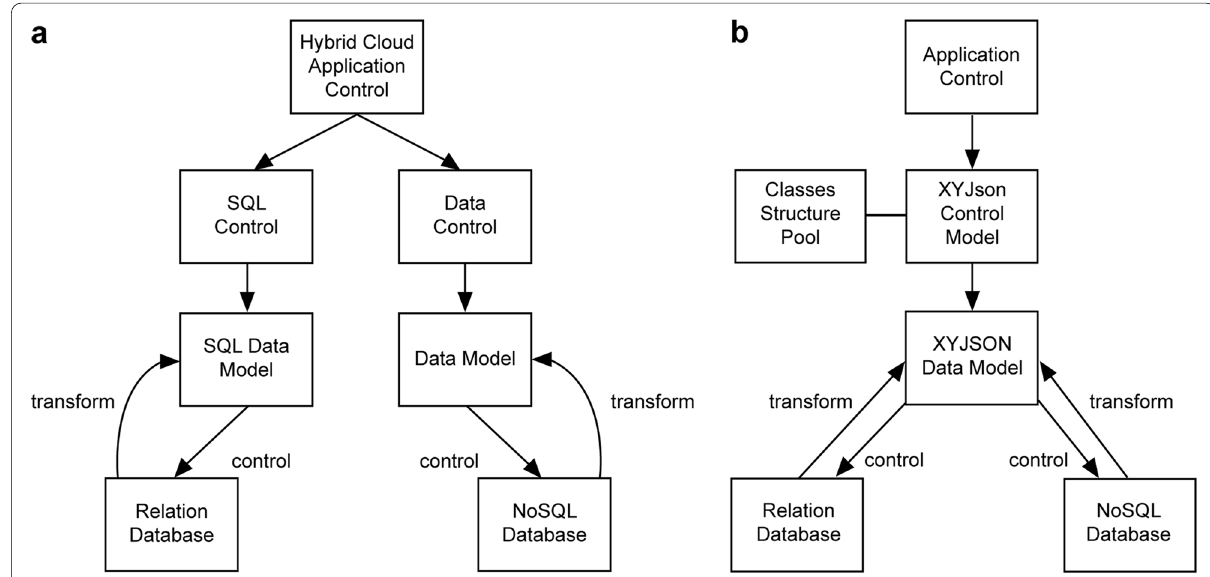
Fig. 1 Comparison of XYJSON and traditional hybrid database control structures ( a ) Traditional hybrid database control structure ( b ) XYJSON hybrid database control